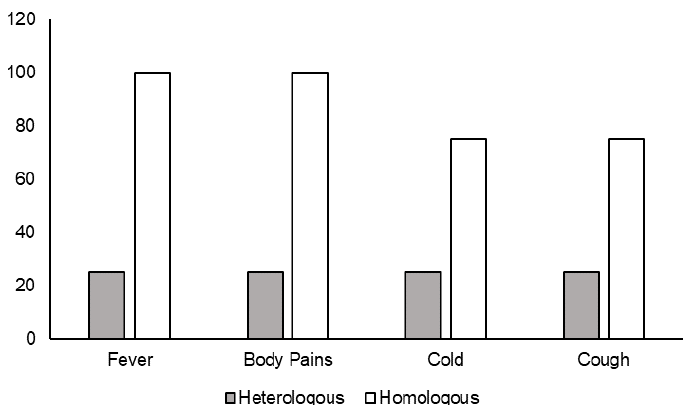
Figure 5. Clinical symptoms in individuals infected 14 days after receiving heterologous and ho- mologous booster